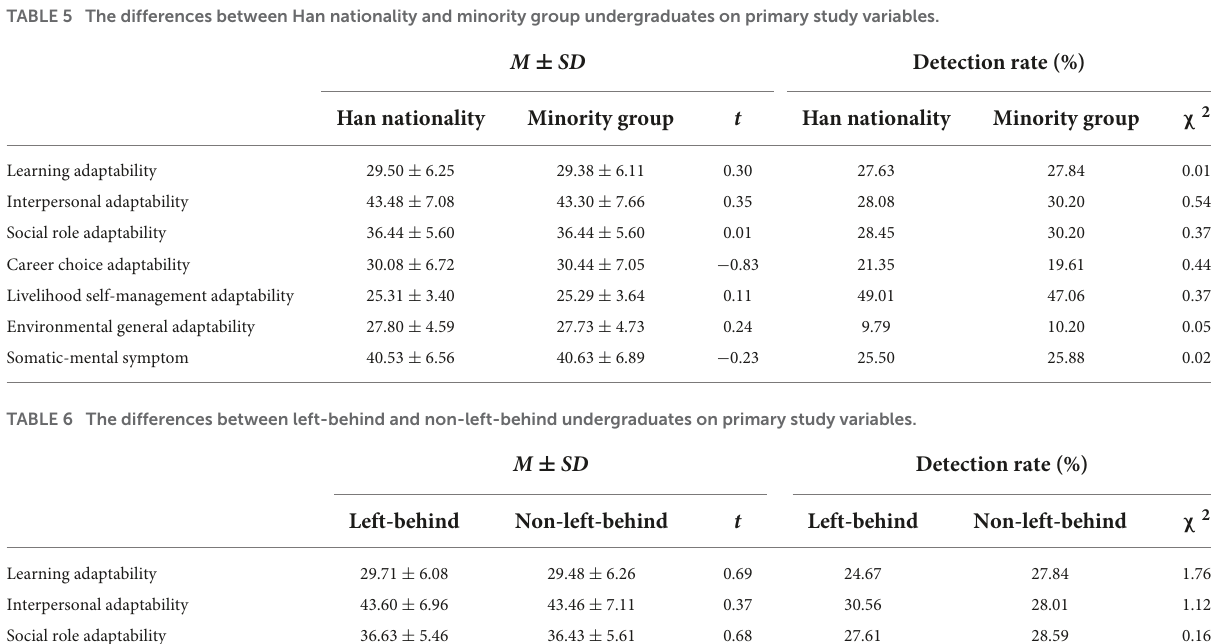
TABLE 5 The differences between Han nationality and minority group undergraduates on primary study variables.